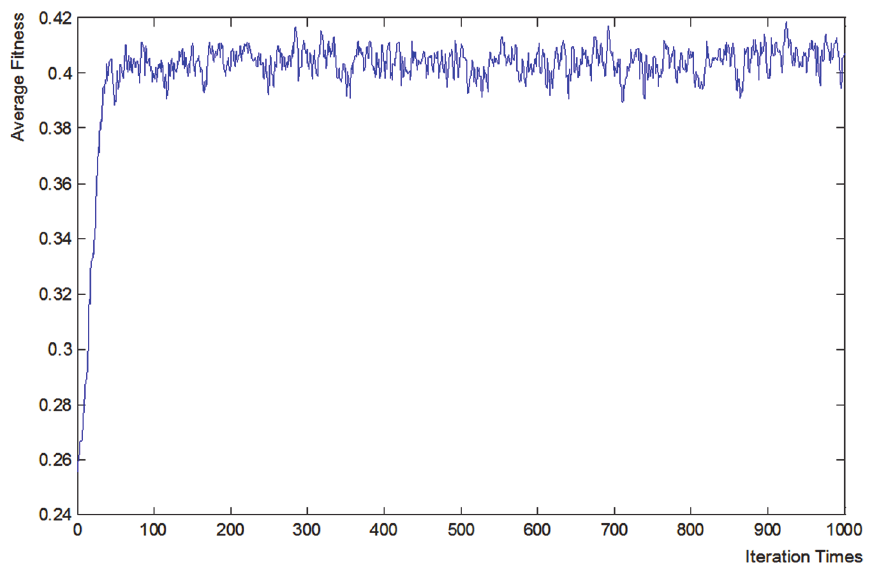
Figure 9. Relationships between population average fitness and iteration times under dynamic